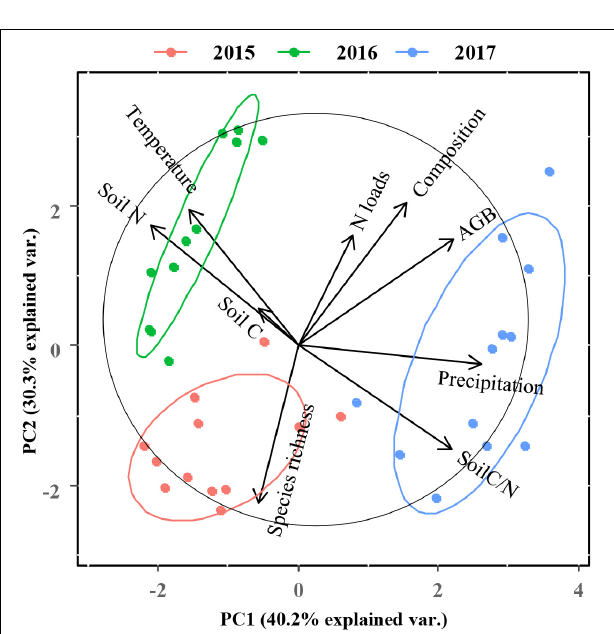
FIGURE 7 | Principal component analysis (PCA) for all plant community parameters, soil properties, temperature, and precipitation across different N addition rates during the 3-year field study. The length of a variable vector in the representation space is indicative of the contribution level of the variable. Composition is expressed as graminoid cover/non-graminoids (i.e., graminoid dominance). AGB, aboveground